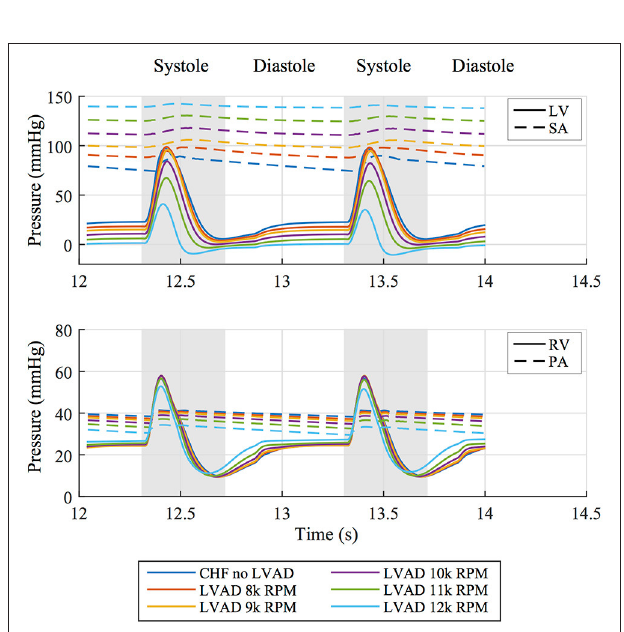
FIGURE 5 | (Top) Pressure tracings of the LV and systemic arterial compliance (SA) over two cardiac cycles for all simulated cases. (Bottom) Pressure tracings of the RV and pulmonary arterial compliance (PA) over two cardiac cycles for all simulated cases.